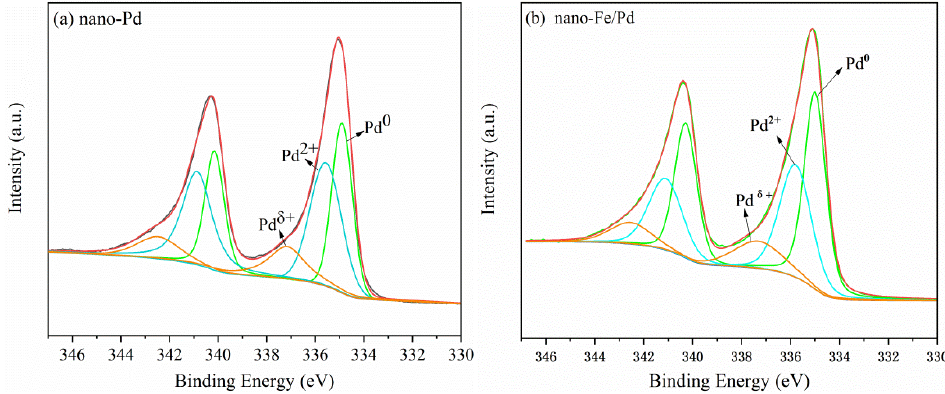
Figure 4. High resolution Pd 3d XPS spectra of nano-Pd ( a ) and nano-Fe/Pd ( b ).